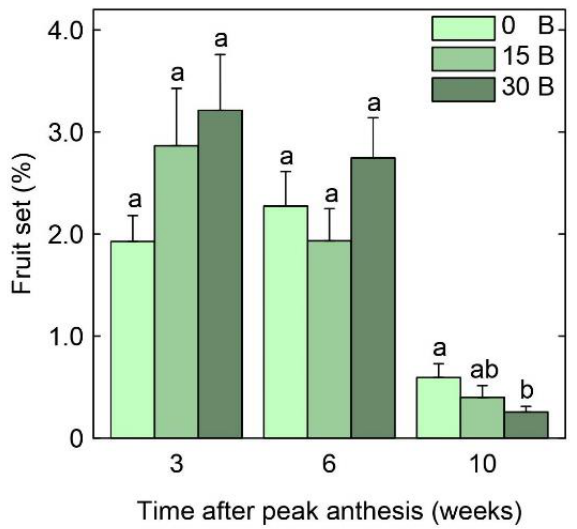
Figure 3. Fruit sets of Hass avocado trees at 3, 6 and 10 weeks after peak anthesis. Trees were treated with 0, 15 or 30 g boron (B) per tree prior to anthesis. Means (+SE) with different letters within a time point are significantly different (generalised linear models, p < 0.05, n = 30 panicles).